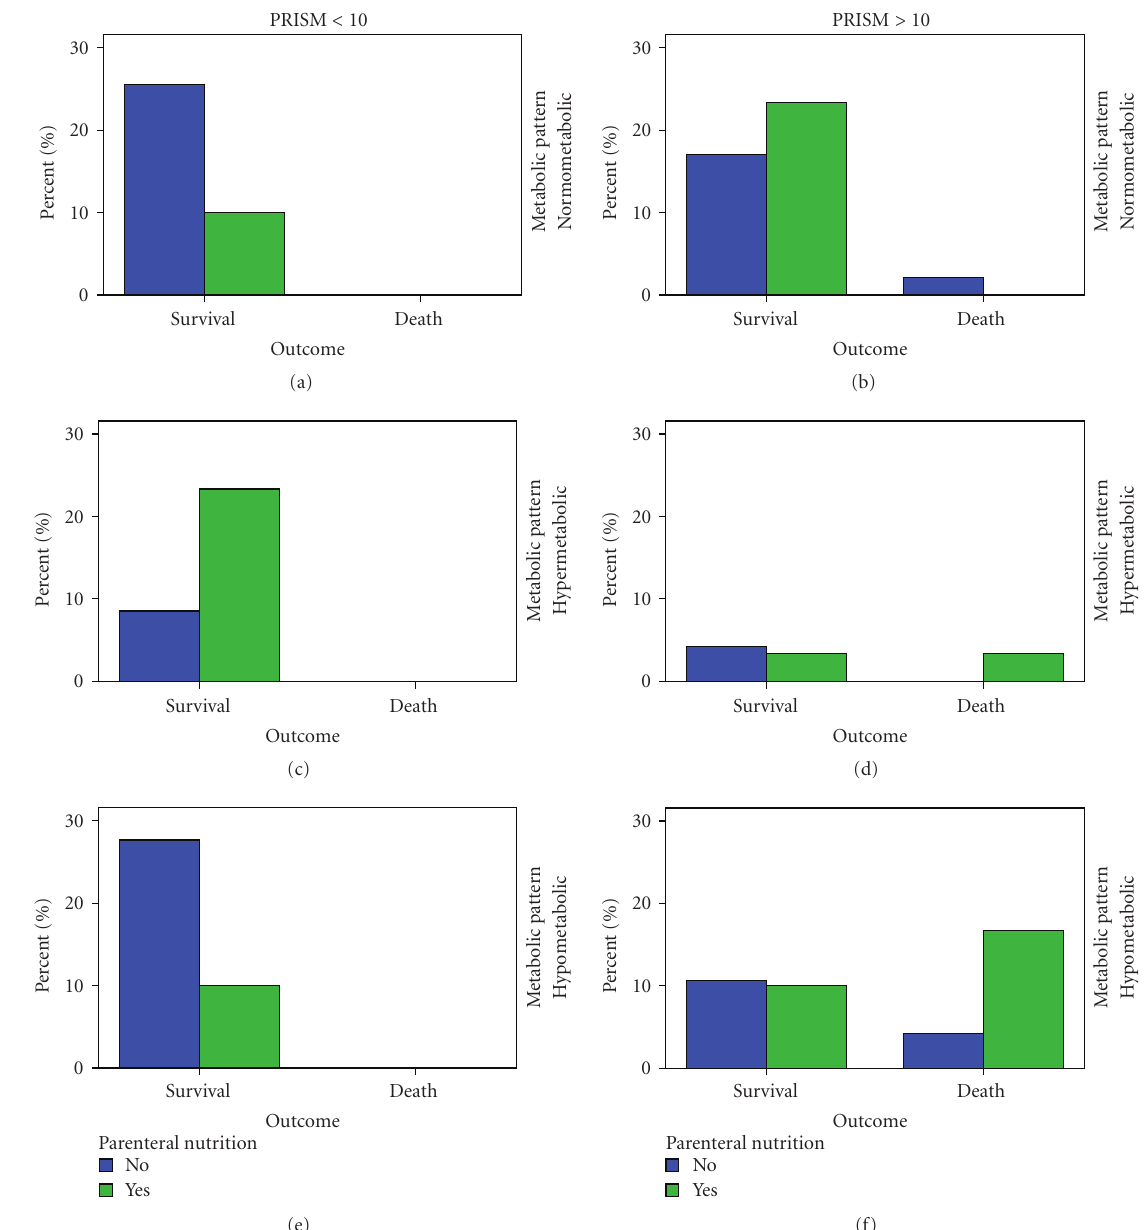
Figure 6: Mortality was (i) significantly higher (Pearson chi-square, asymptomatic significance 2-sided P < . 05) in the hypometabolic pattern (22.6%) compared to the hypermetabolic (6.7%) or normometabolic patterns (3.2%), (ii) exclusively restricted to patients with Pediatric Risk of Mortality Score (PRISM) > 10 (25.7% versus 0, P < . 0001), and (iii) increased among those receiving partial or Total Parenteral Nutrition (TPN) (20% versus 6.4%, P = .